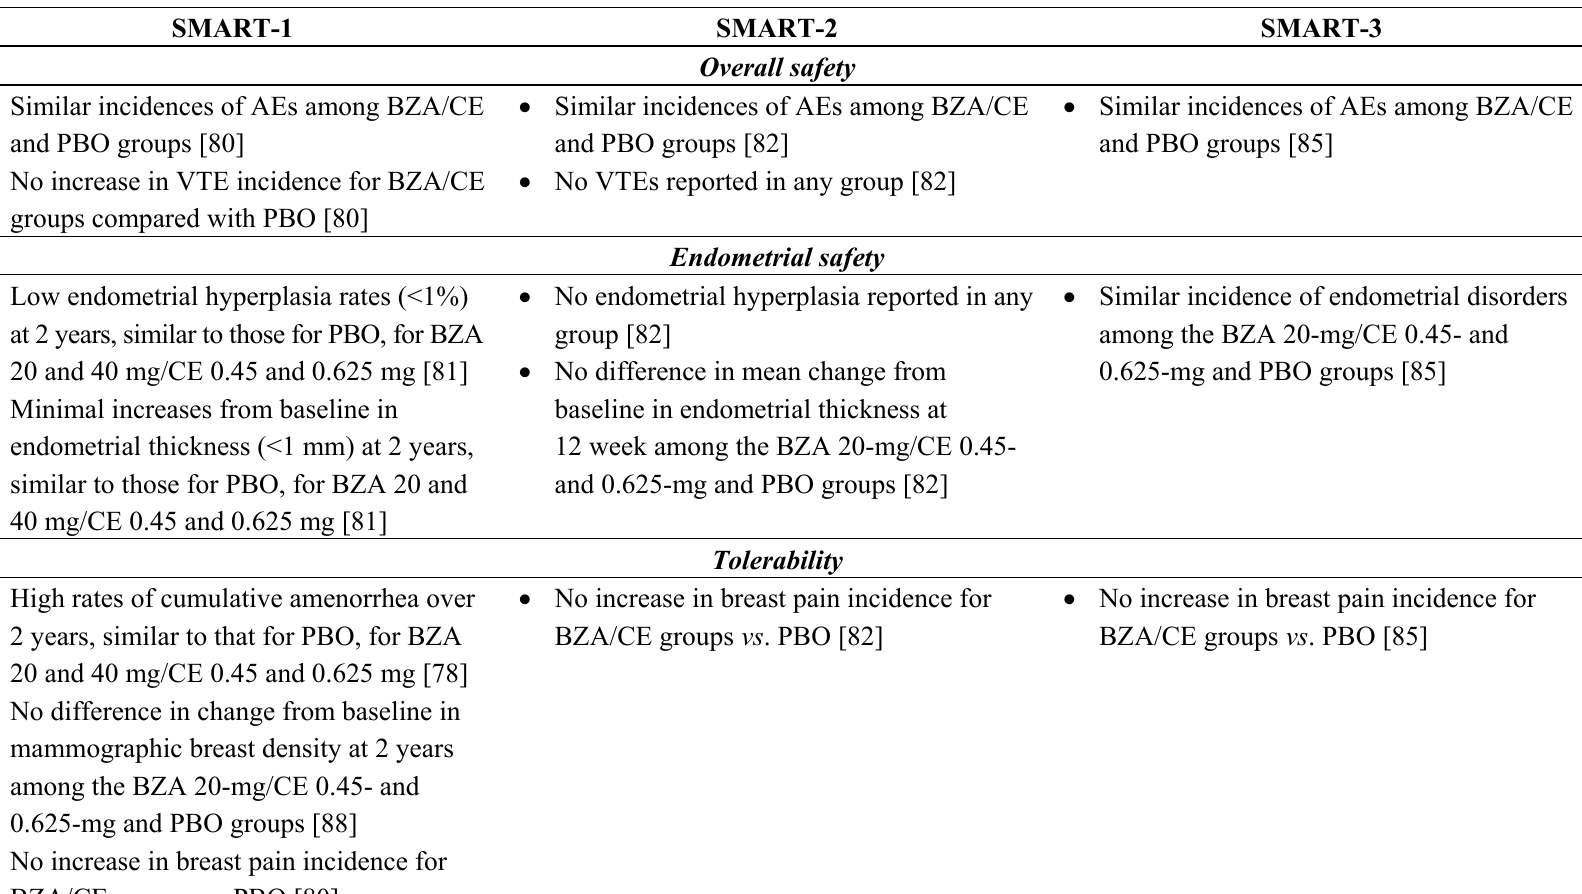
Table 4. Summary of key safety findings in the SMART